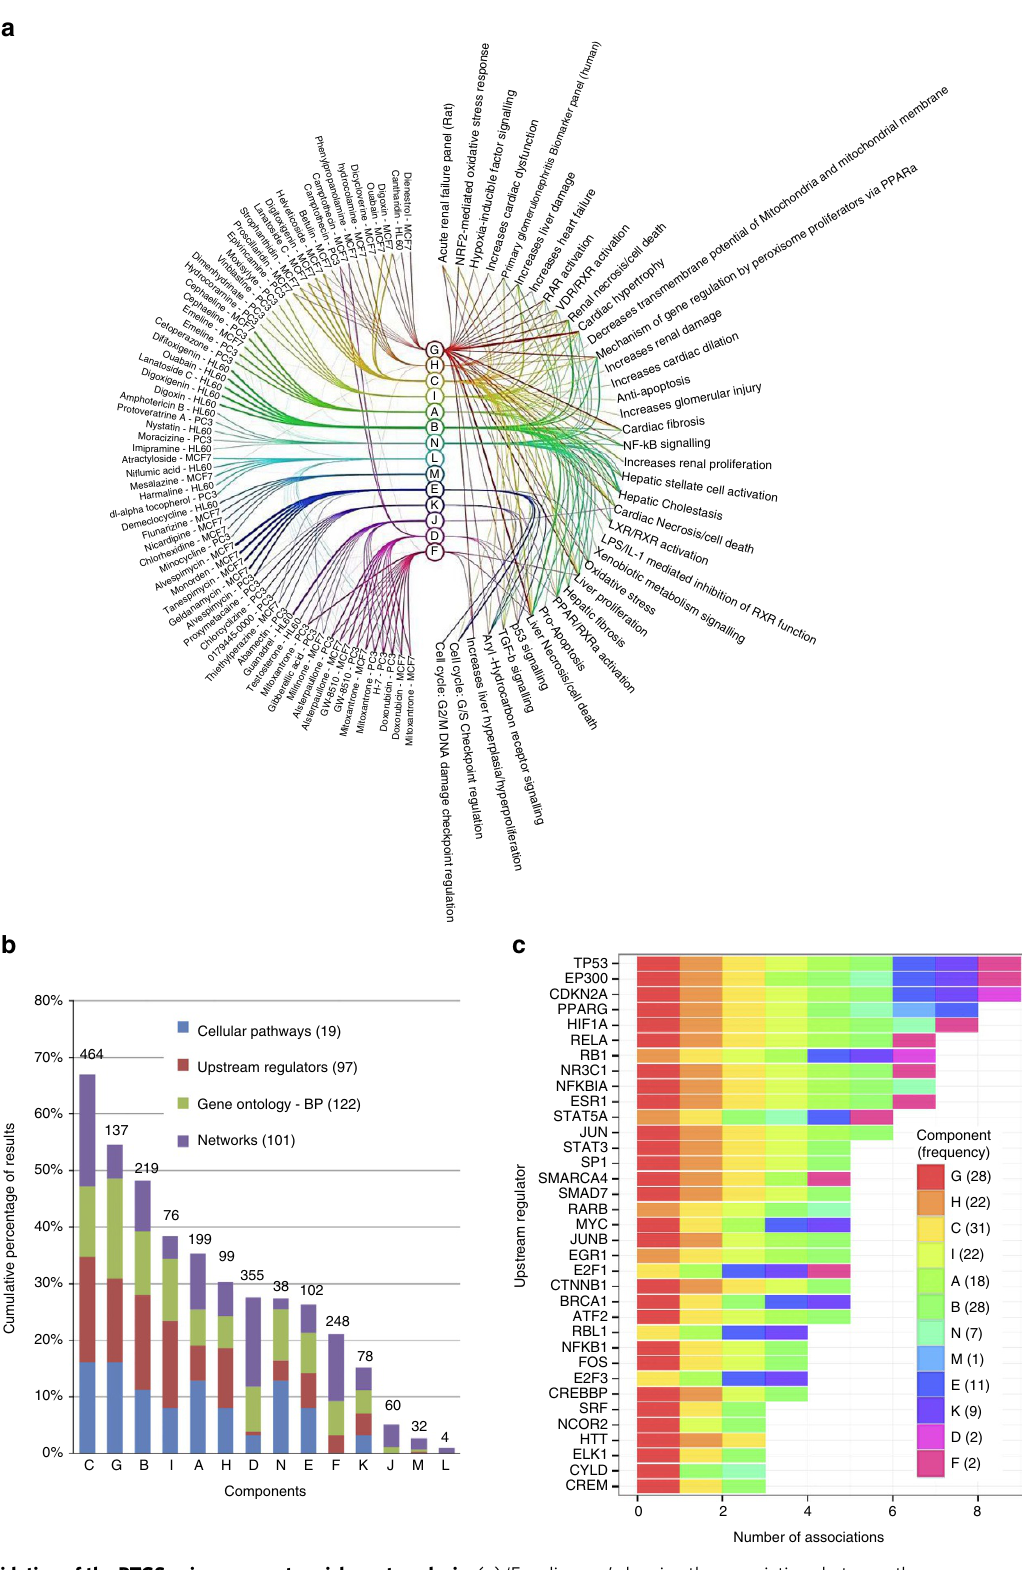
Figure 3 | Validation of the PTGS using gene set enrichment analysis. ( a ) ‘Eye diagram’ showing the associations between the genes associated with the 14 PTGS components (middle, colour) and the top 5 CMap instances (left) and overrepresented toxicological functions (right). Line widths indicate association strengths. The components have been sorted according to similarity, as shown in Supplementary Fig. 3b; data in Supplementary Data 4. ( b ) Biological and toxicological complexity of the PTGS components defined as the proportion of results (above a set statistical threshold) in each analysis category ascribed to the component gene set. Numbers above bars denote the numbers of genes in each component. Details of the data are found in Supplementary Data 3–7. ( c ) Frequency plot of the upstream regulator enrichments for the PTGS components depicting multiple transcriptional regulators associated with stress responses, inflammation and with cell division. For data and further related analyses, see Supplementary Fig. 6b and Supplementary Data